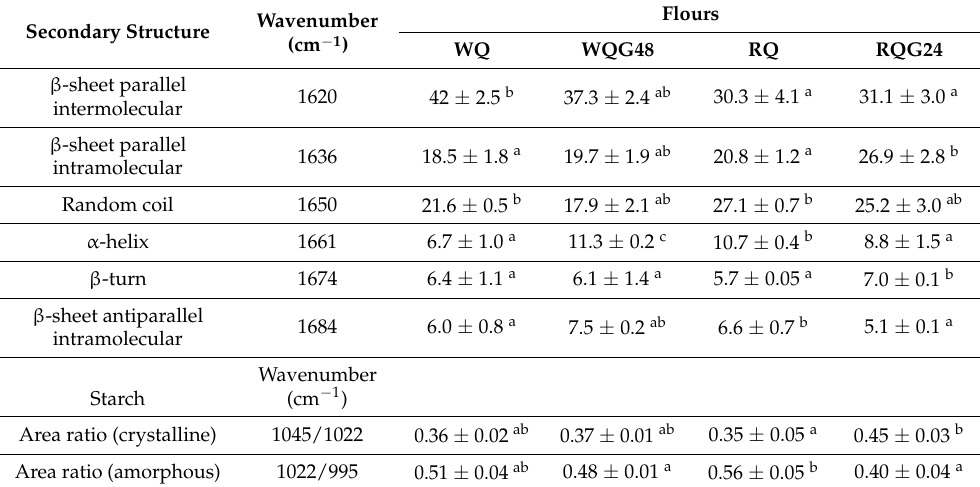
Table 3. Wavenumber, protein secondary structure percentage (Amide I) and starch structure ratio of ungerminated and sprouted white and red quinoa